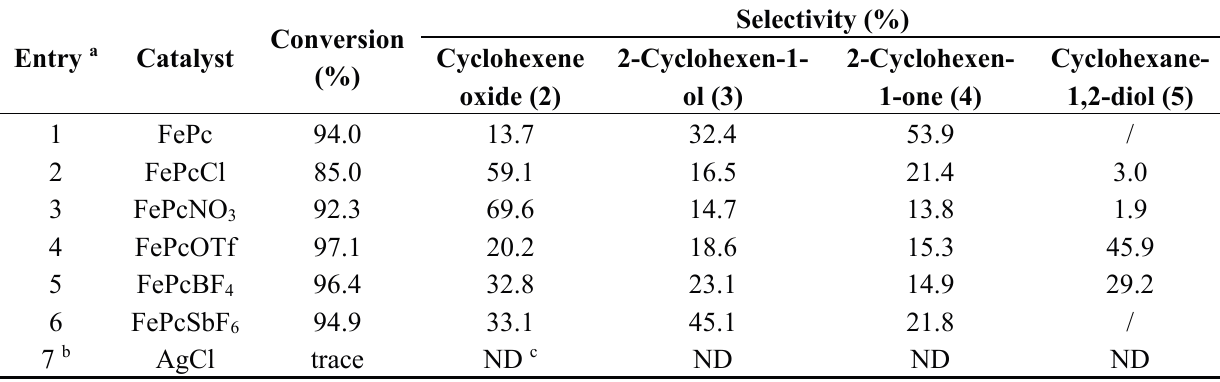
Table 1. The selective oxidation of cyclohexene to 1,2-diols catalyzed by iron (III) phthalocyanines with different counter anions by using H 2 O 2 as an